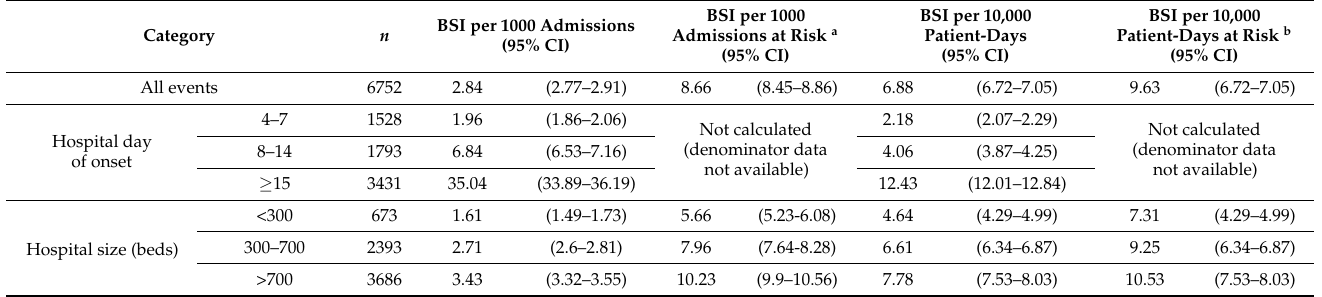
Table 2. Incidence rates of hospital-onset bloodstream infections (HO-BSIs) caused by sentinel bacteria among adult patients, Israel,